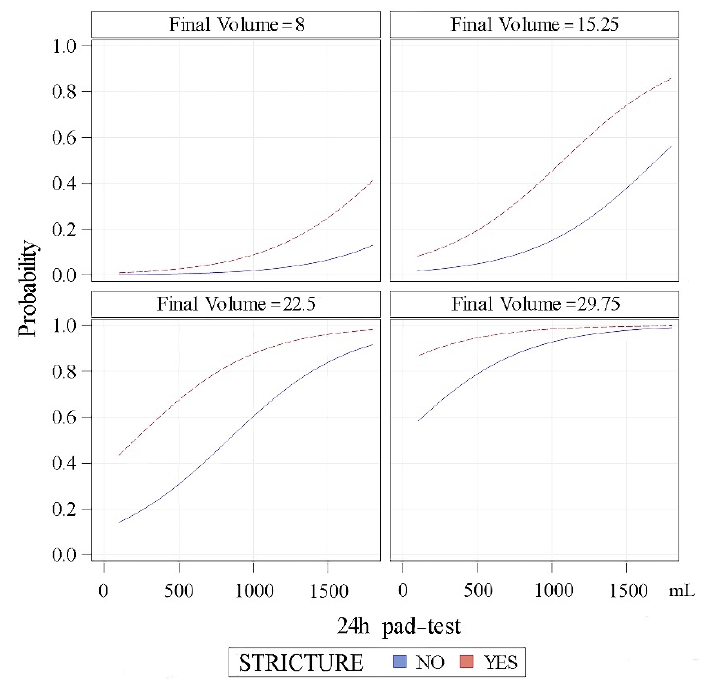
Figure 4. Predictive probabilities of patients achieving dryness (24-h pad test ≥ 20 mL after adjust- ment) regarding stricture history, 24-h pad test and filling volume.